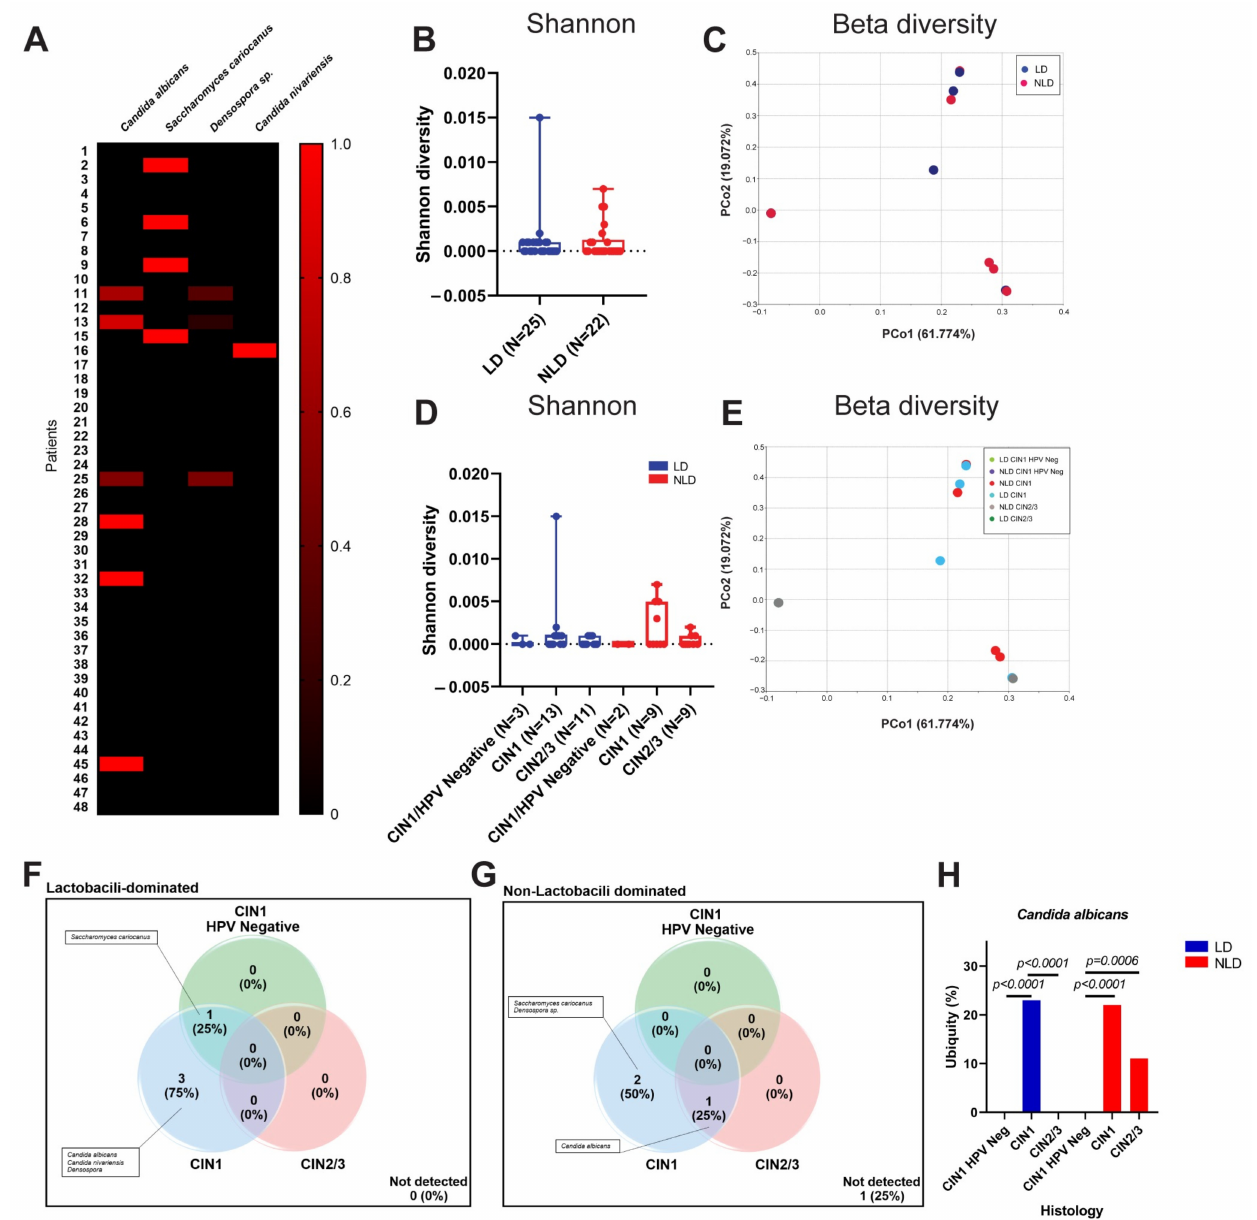
Figure 4. The composition and diversity of the fungal community in cervical samples. ( A ) Heat map of fungal taxa from cervical samples. Black to red color shades represent increasing relative abundance. The fungal diversity between LD and NLD groups: alpha (Shannon) diversity ( B ) and beta diversity ( C ). Fungal diversity among different histological groups: alpha (Shannon) diversity ( D ) and beta diversity ( E ). Error bars represent the standard error of the mean (SEM). Venn diagram represents numbers of unique and shared fungal OTU in different histological groups: LD ( F ) and NLD ( G ). The ubiquity (%) of the selected taxa: Candida albicans ( H